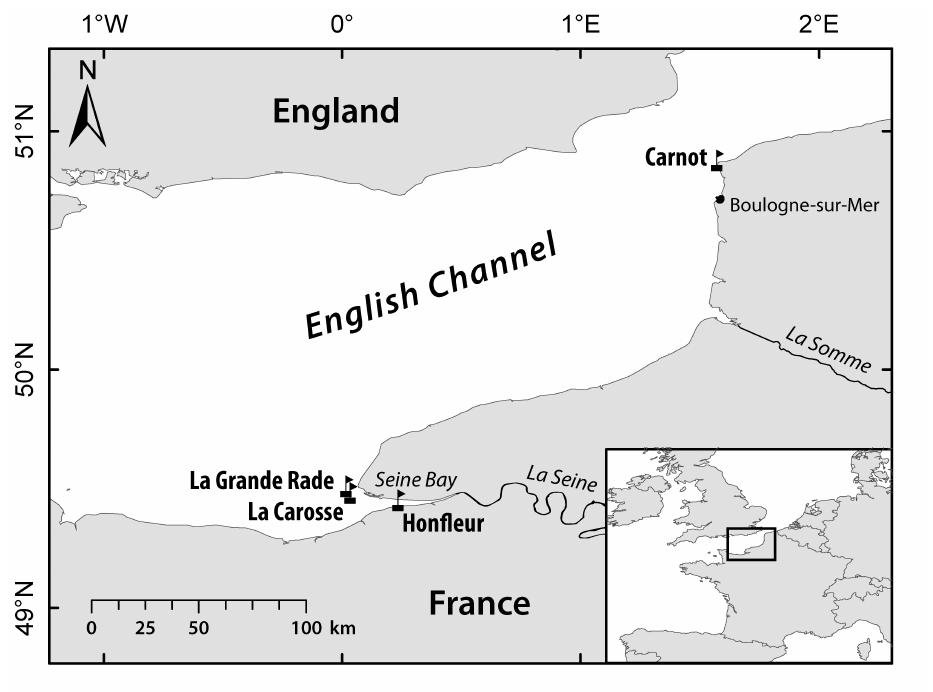
Fig. 1. Map of the location of the measurements in the English Channel. The Seine and Somme rivers are indicated in the map. Table 1. Data description: pH and temperature ( T ). Station La Carosse Grande rade Honfleur Carnot Available data 1999-2004-2007 Time resolution 60min